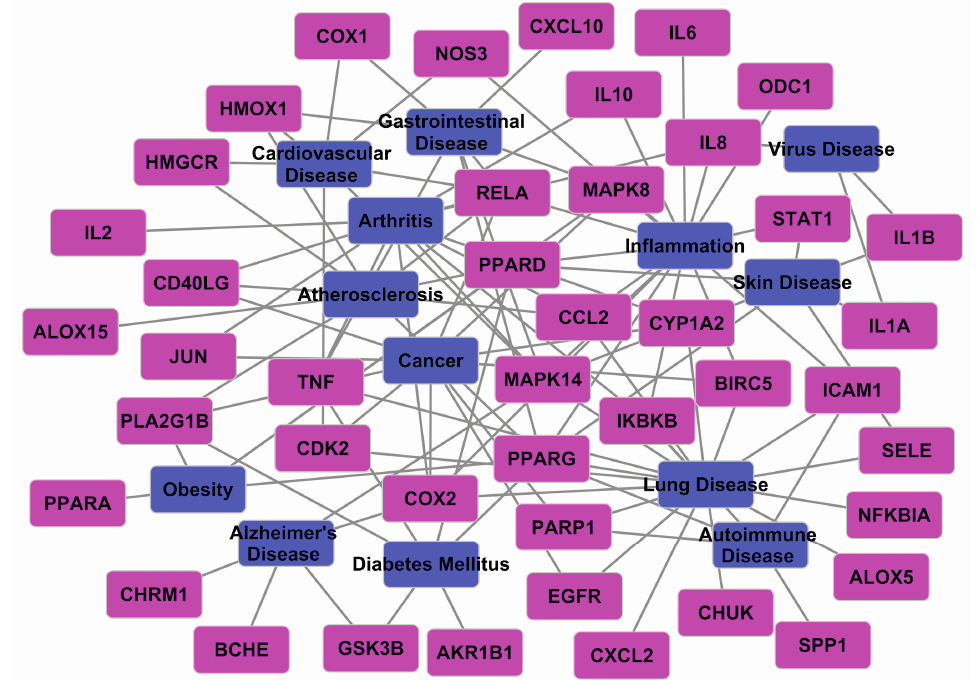
Figure 5. T-D network. The blue nodes show the representative diseases, while the magenta ones the